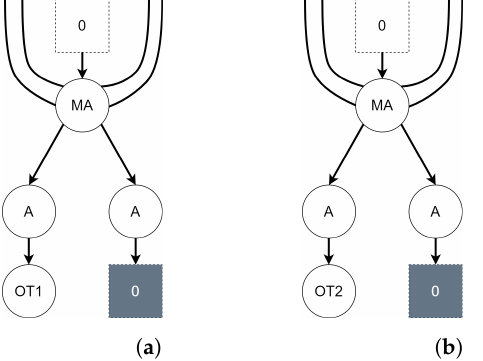
Figure 14. Bigraph patterns to detect whether a collision between robots may occur during a scenario. The two patterns differ only in type of the relocated object. ( a ) The first pattern. ( b ) The second